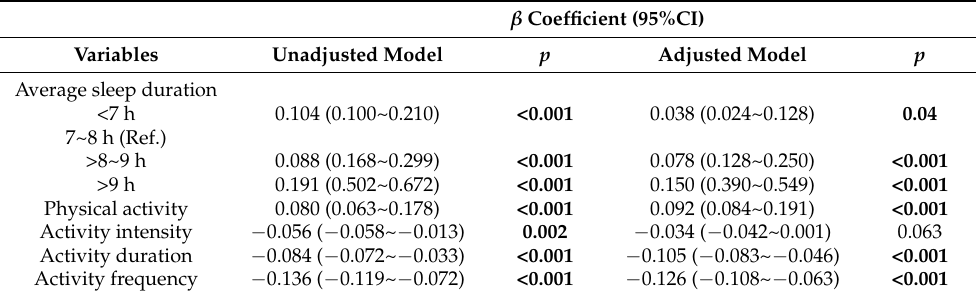
Table 4. Associations of stroke risk with average sleep duration and physical activity by a multiple linear regression analysis.